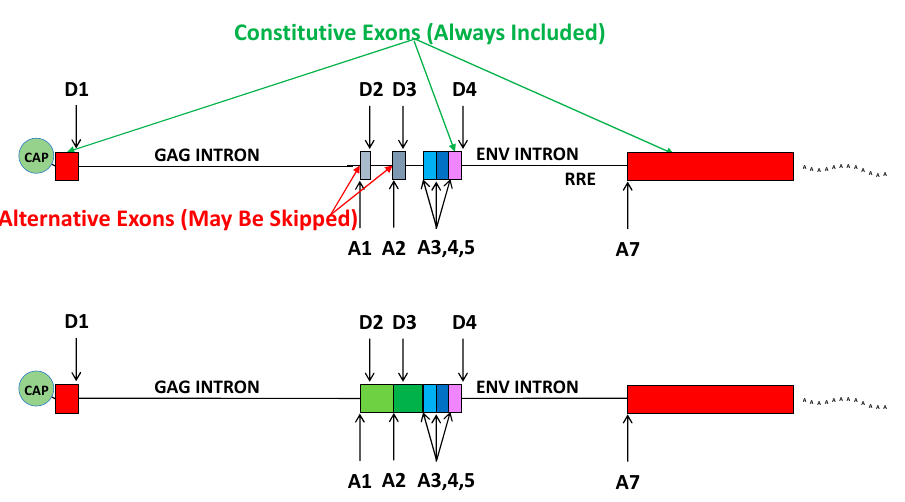
Figure 2. Exons in HIV-1. ( Upper Panel ) The first exon is defined by the cap and D1. The final exon is defined by A7 and the poly A site. The two small alternative exons are defined by A1 and D2, and A2 and D3 (grey). The exon defined by D4 is constitutive, but can use A3, A4, or A5 for the acceptor to define the exon. ( Lower Panel ) D4 can also use A1 or A2 to define the vif or vpr exons respectively, independently of D2 and D3.